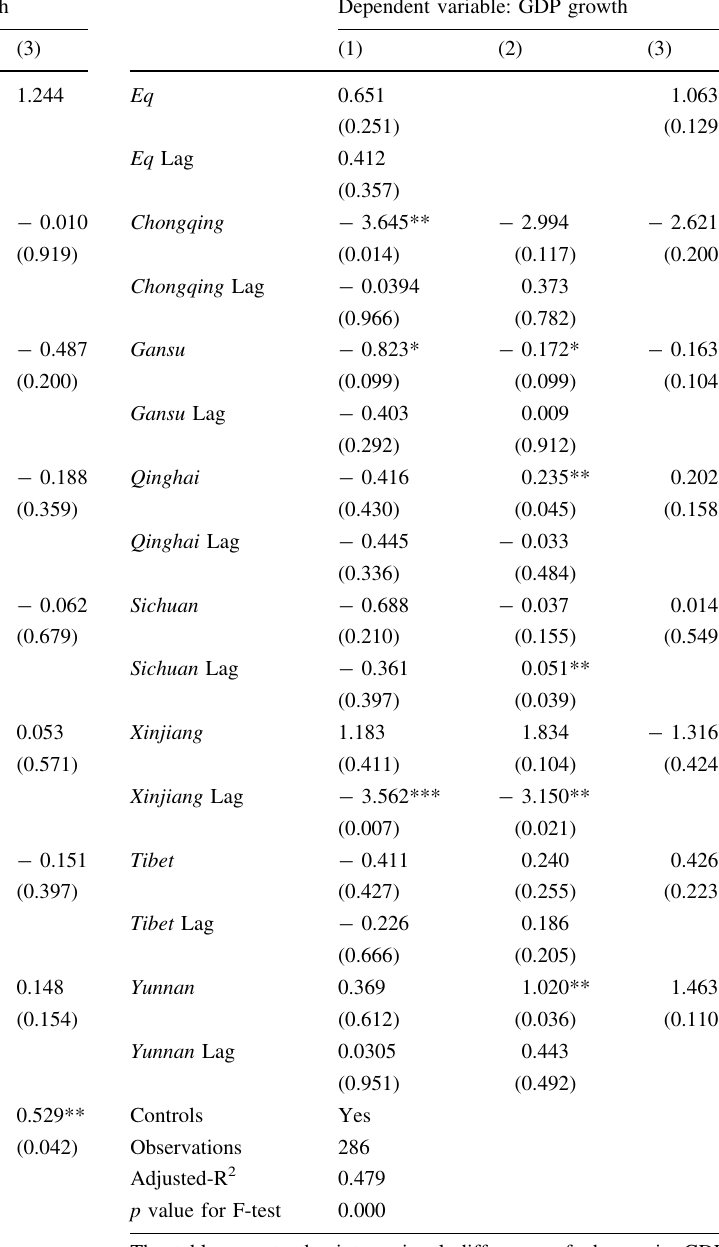
The table reports the intraregional difference of change in GDP growth from earthquakes in western China. All added control vari- ables are listed in Table 1. The associated p values for coefficients are given in